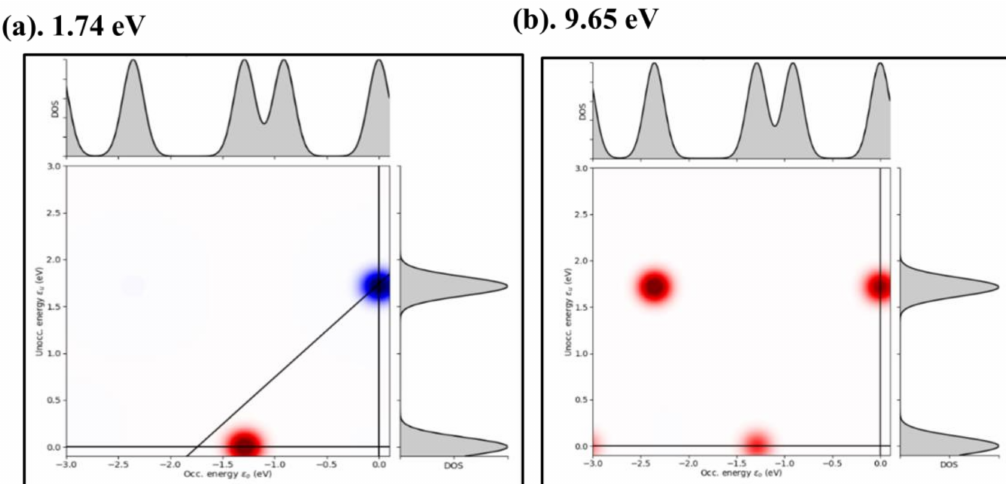
Figure 9. Combined electronic density of states (in states/eV.cell) and the optical transition contribution map at extremal energies 1.74 eV ( a ). 9.65 eV ( b ). In the photon absorption spectrum of the graphene system. Blue and red colors indicate net deficit and surplus of electron density,